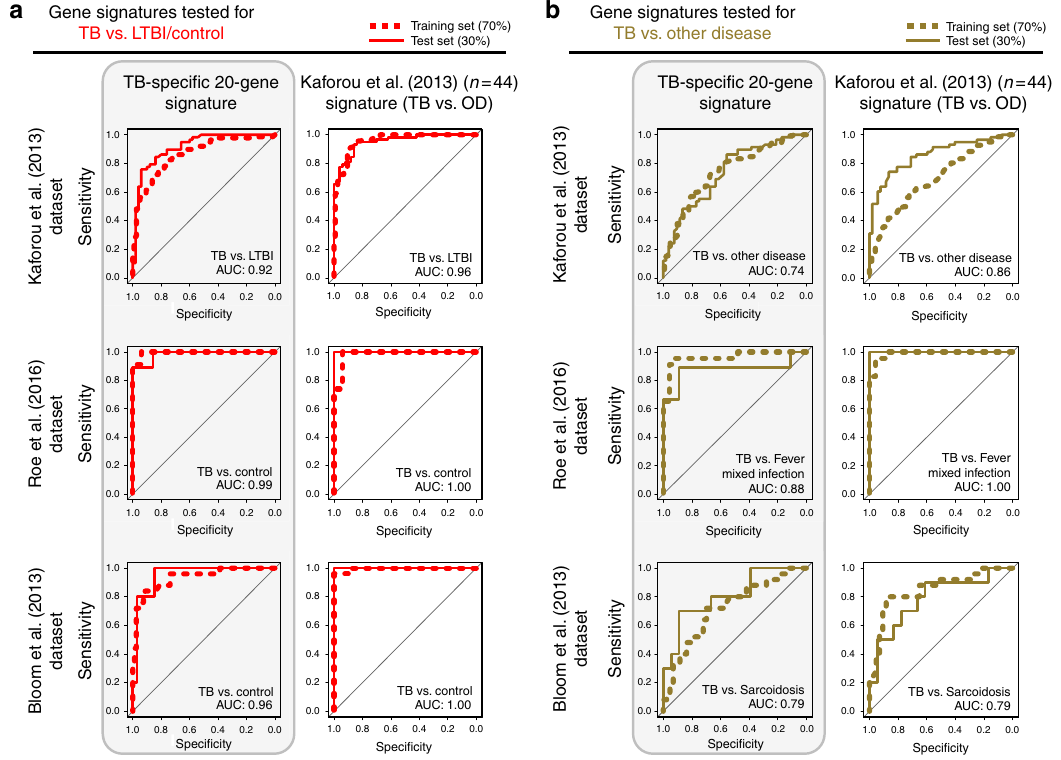
Fig. 7 Comparison of our TB-speci fi c 20-gene signature with Kafourou et al. in distinguishing TB and other diseases. a Receiver operating characteristic (ROC) curves depicting the predictive potential of the TB-speci fi c 20-gene signature and the 44-gene (TB vs. other diseases (OD)) signature from Kaforou et al. 24 in classifying a sample as TB or LTBI/Control, or b in classifying a sample as TB or other disease in datasets from Kaforou et al. 24 , Roe et al. 27 and Bloom et al. 10 . Area under the curve (AUC) is shown for each ROC